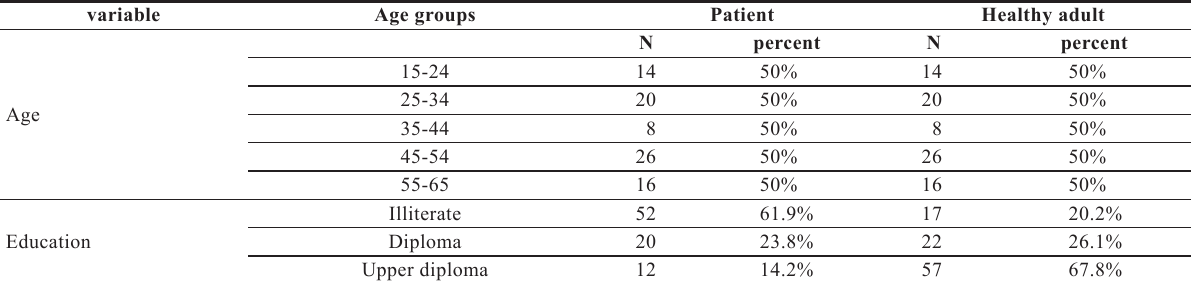
Table 1. Age and education in detail.